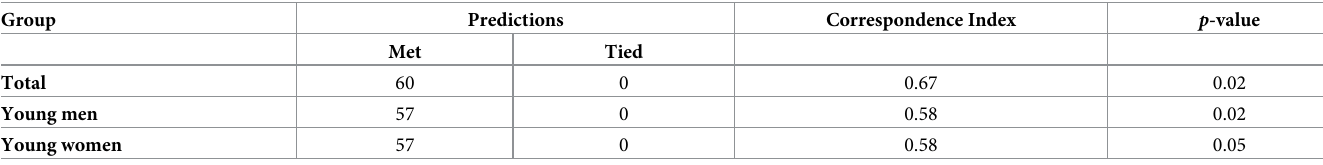
Table 4. Randomization test of hypothesized order relations.